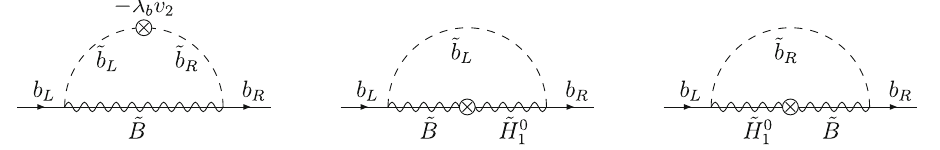
Fig. 3 One-loop diagrams of sbottom-self-energy insertions contributing to the SUSY–QCD corrections (cid:9) el w, 1 involving bottom quarks b , bottom squarks ˜ b , binos ˜ B and higgsinos ˜ H 0